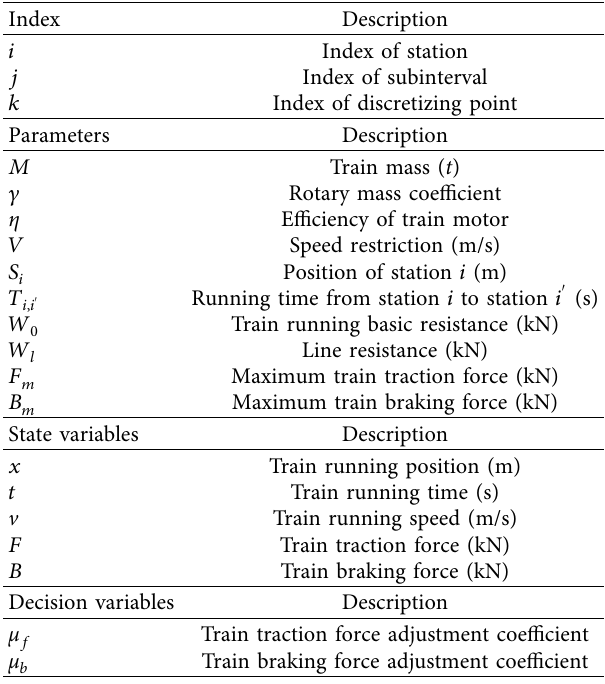
Table 1: Notations and